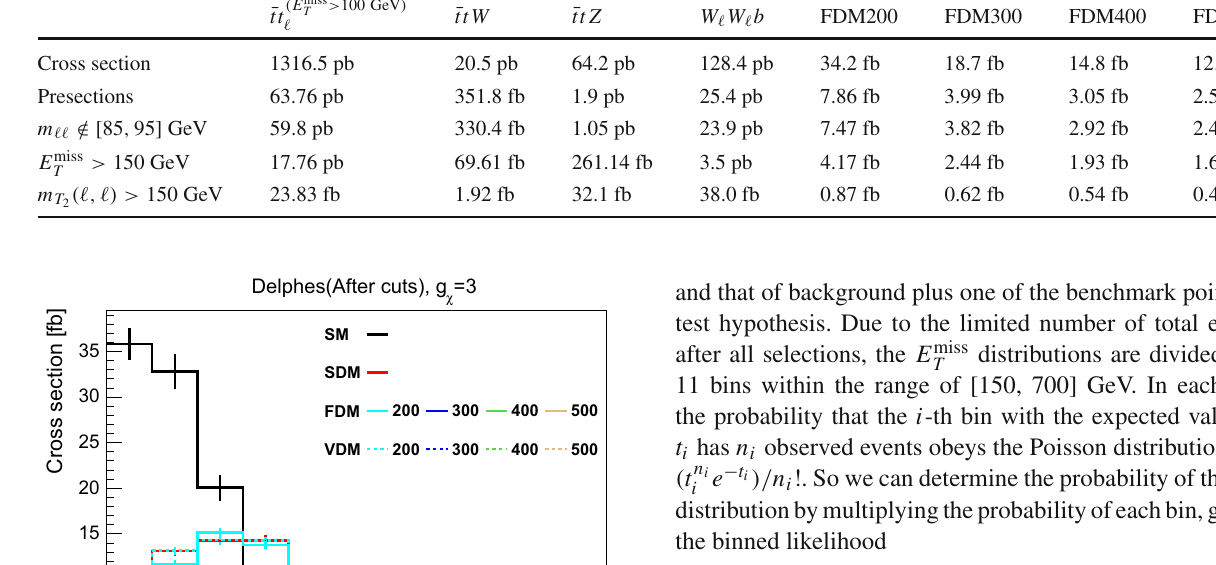
Table 2 Cut flows for the SM background and FDM processes. The cross sections of signals in the second row include the branching ratios of leptonically decaying tops. Here ¯ tt (cid:11) means that at least one (anti)top decays leptonically, W (cid:11) corresponds to leptonic decay of W boson ¯ tt ( E miss T > 100 GeV ) (cid:11)